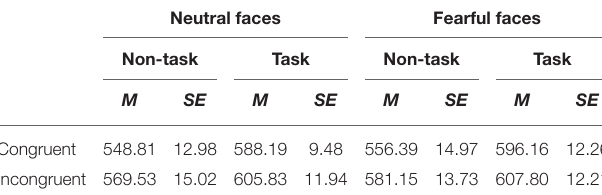
TABLE 1 | Mean, minimum and maximum number of trials for all the experimental conditions.